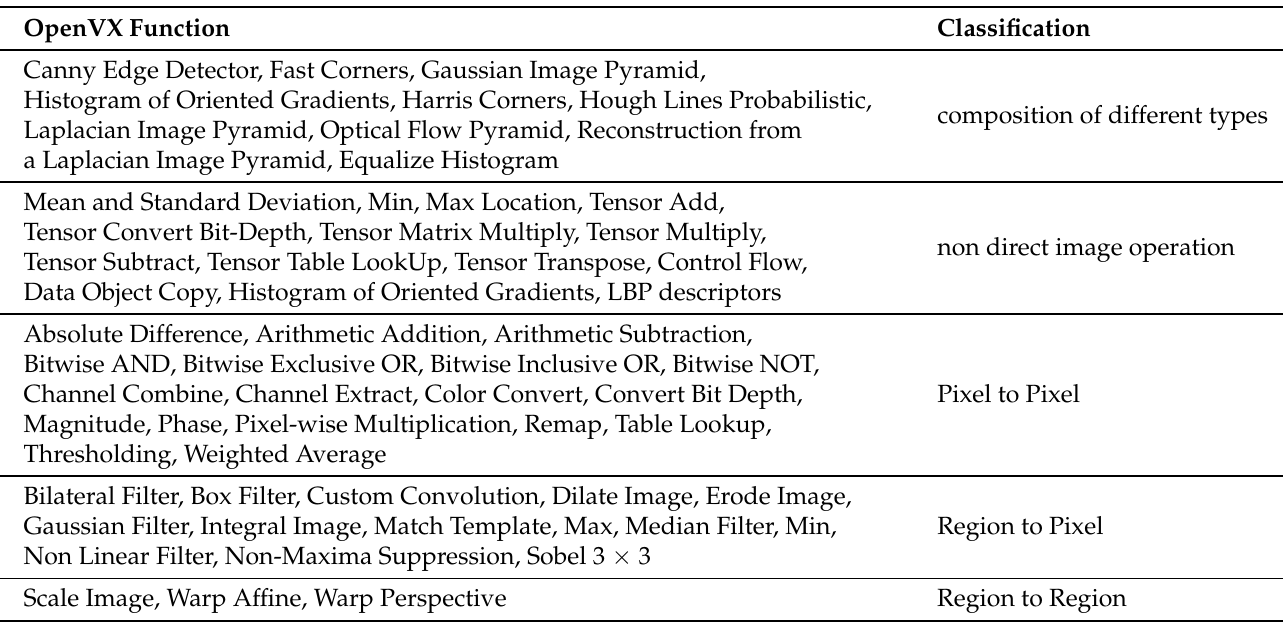
Table 2. Classification of the 58 OpenVX functions by operation